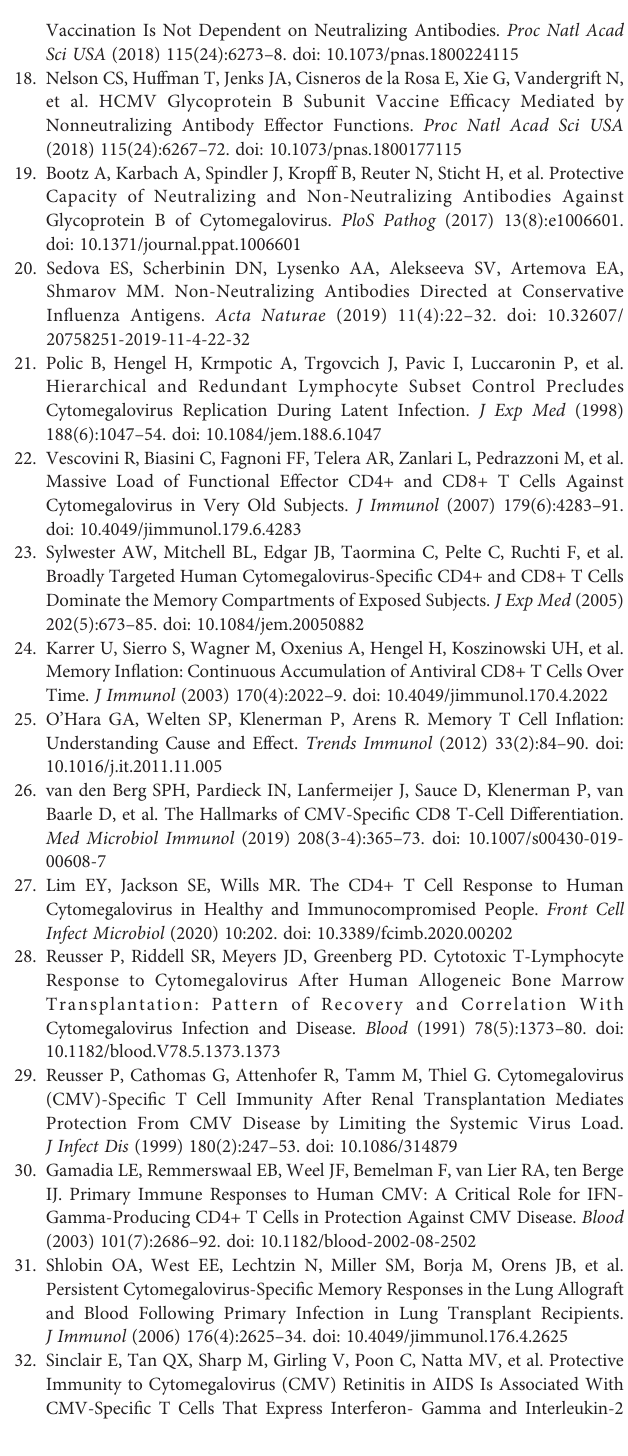
Supplementary Figure 1 | (A) Representative fl ow cytometry gating of tetramer- positive CD8 + T cells. (B) M38- and m139-speci fi c IgG antibody response on day 72 upon vaccination. (C) Intracellular IFN- g production of CD4 + T cells in blood at day 79 after DNA, SLP or combined DNA/SLP vaccination. Blood single